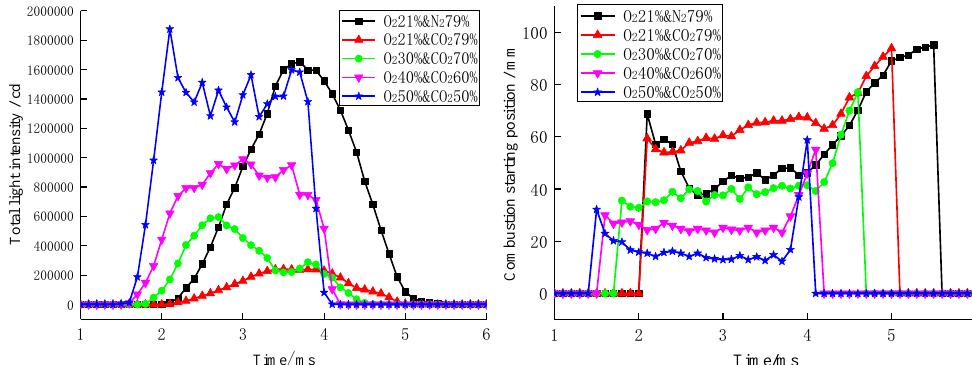
Figure 5. Comparison of the total light intensity and combustion starting position of combustion flames at various times in nitrogen-free conditions.